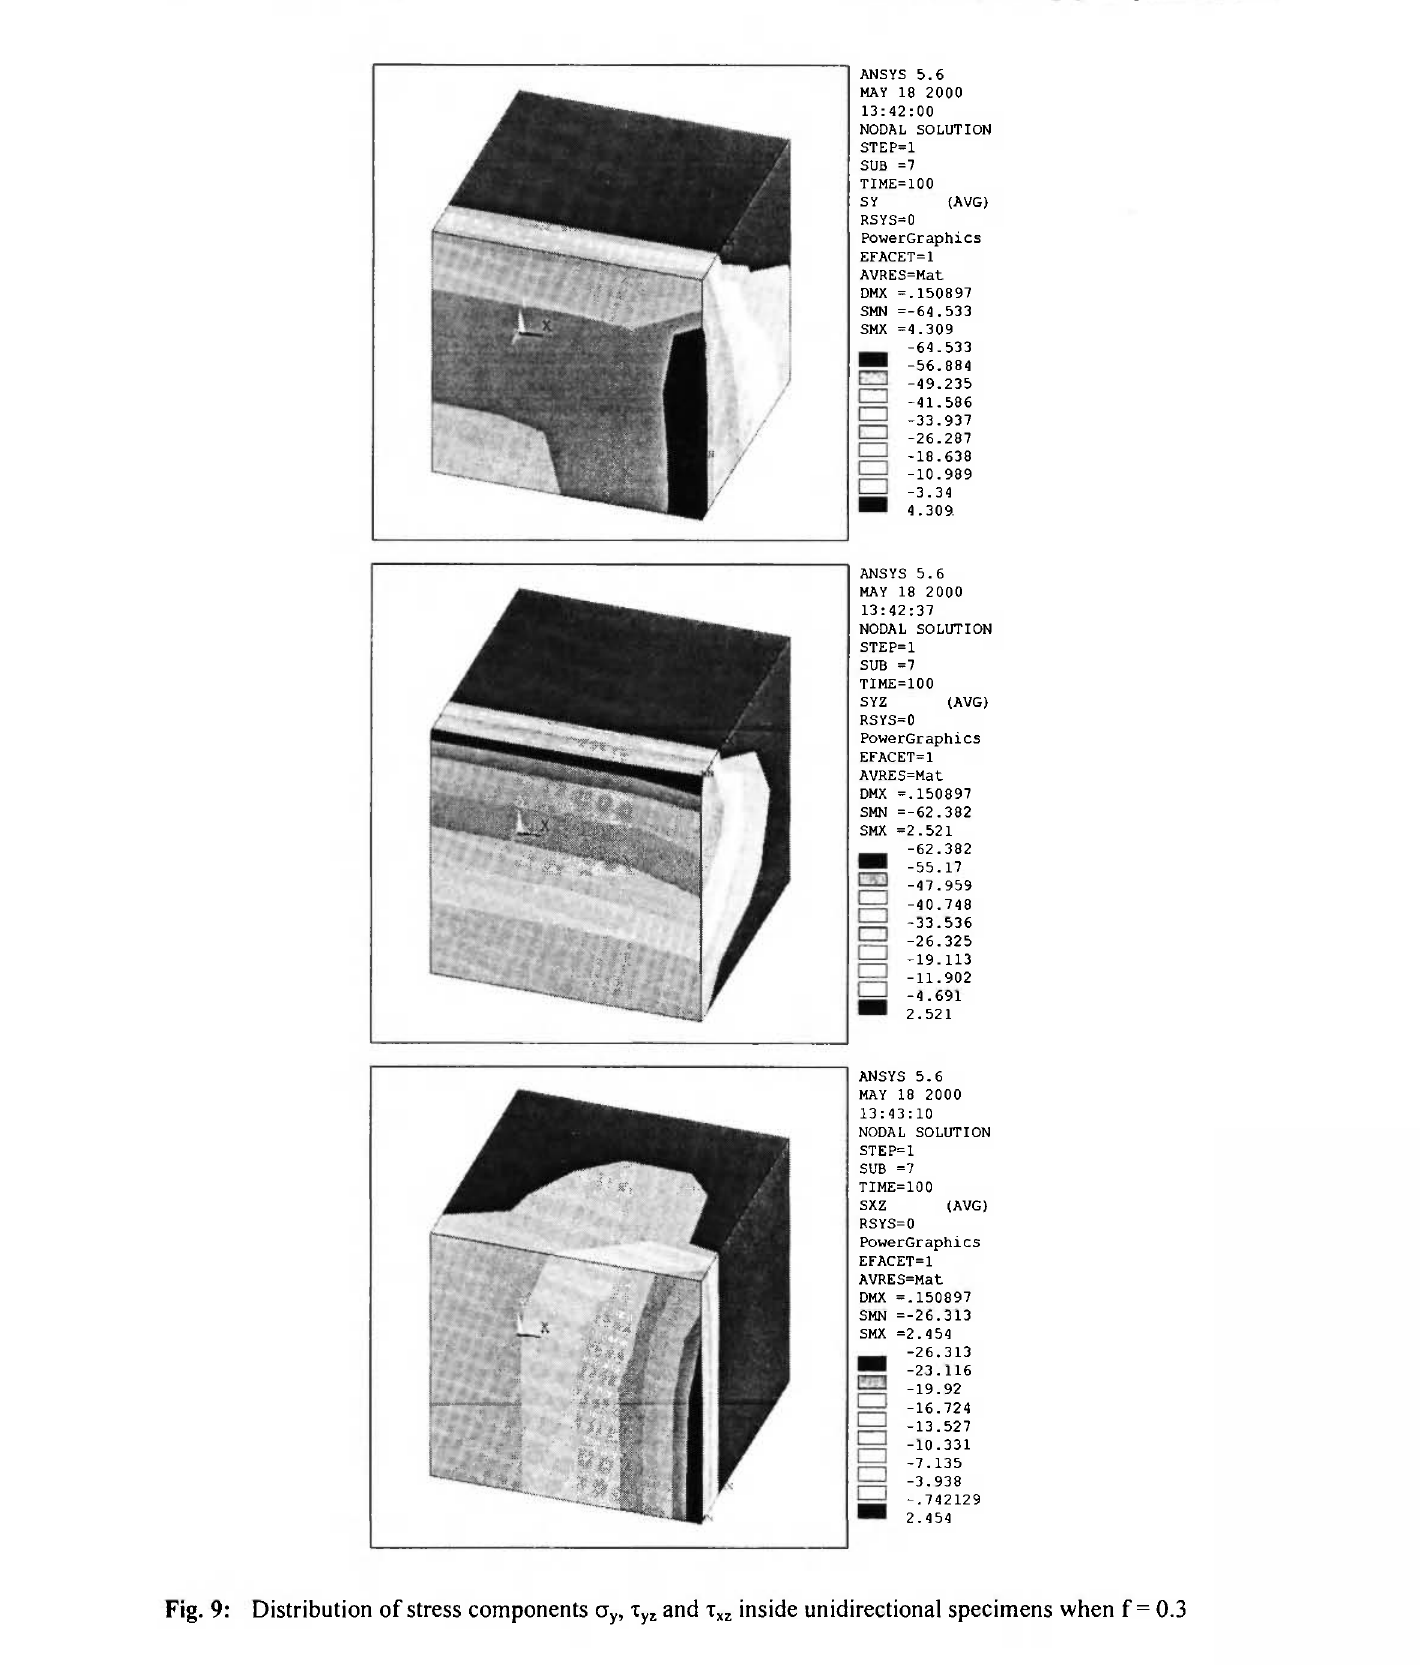
Fig. 9: Distribution of stress components a y , x yz and τ χζ inside unidirectional specimens when f =